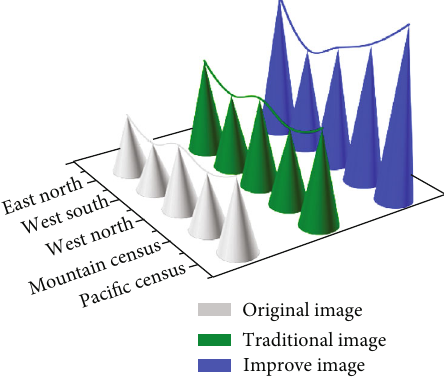
Figure 5: Comparison of mean